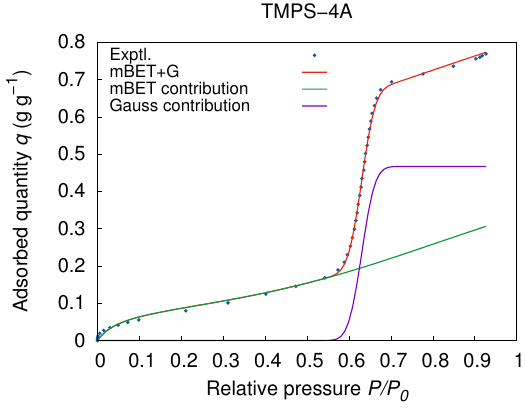
Figure 8. mBET+G model contribution analysis of individual model parts for TMPS-4A at 25 ◦